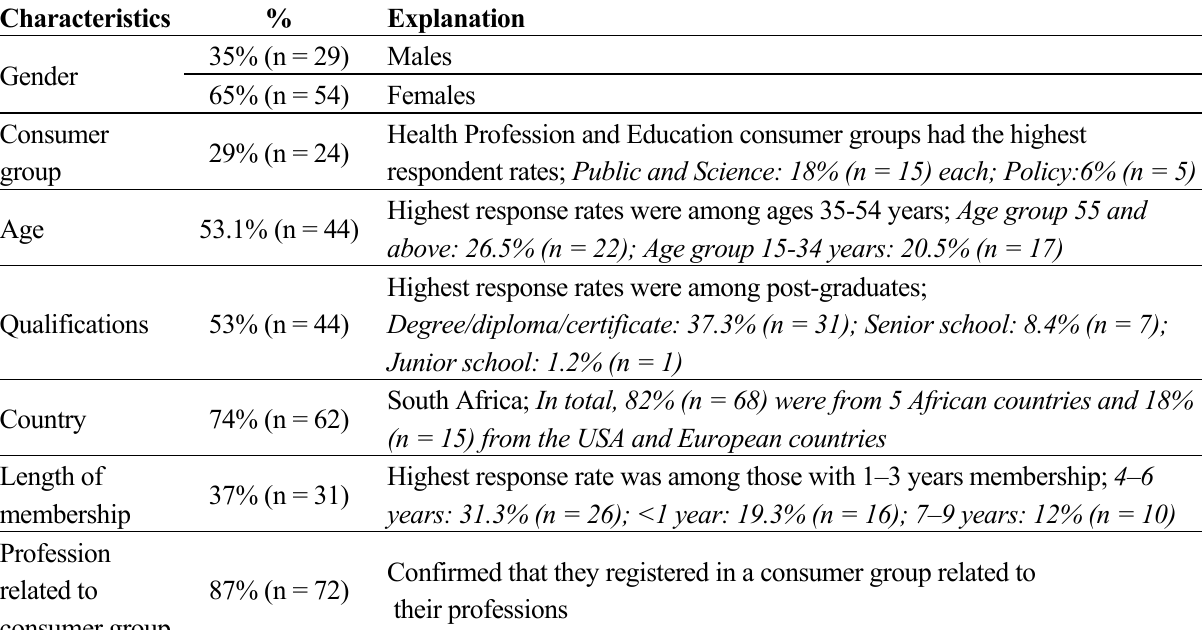
Table 1. Demographic profile of respondents (n = 83).